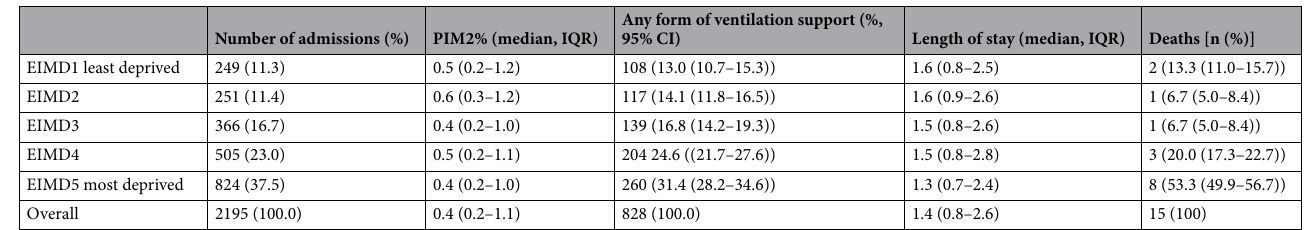
Table 3. Severity and outcomes of PICU admissions with asthma as primary diagnosis or as underlying condition for death, by socio-economic status in England during 2006–2007 to 2012–2013.